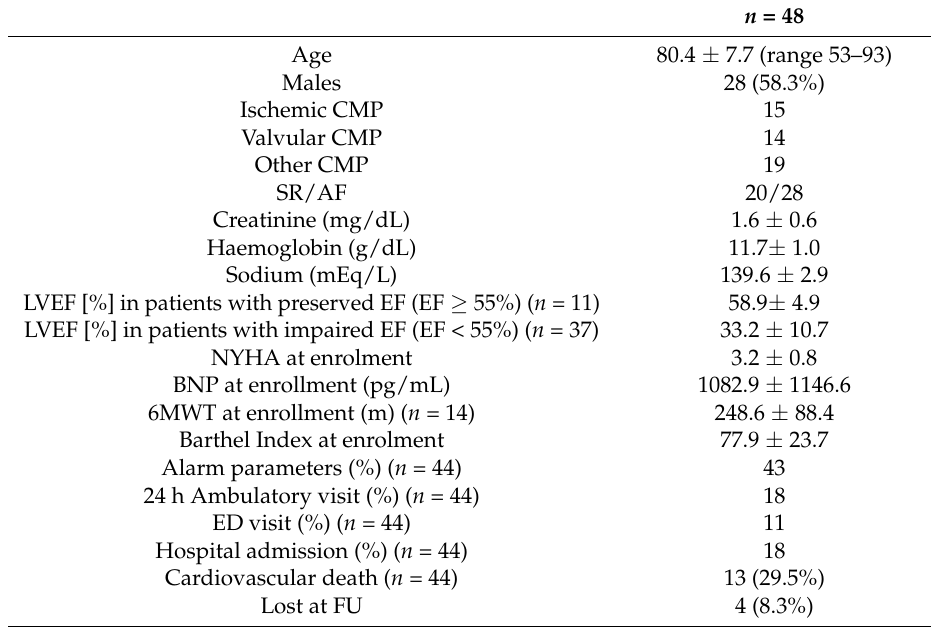
Table 1. Main characteristics of the population